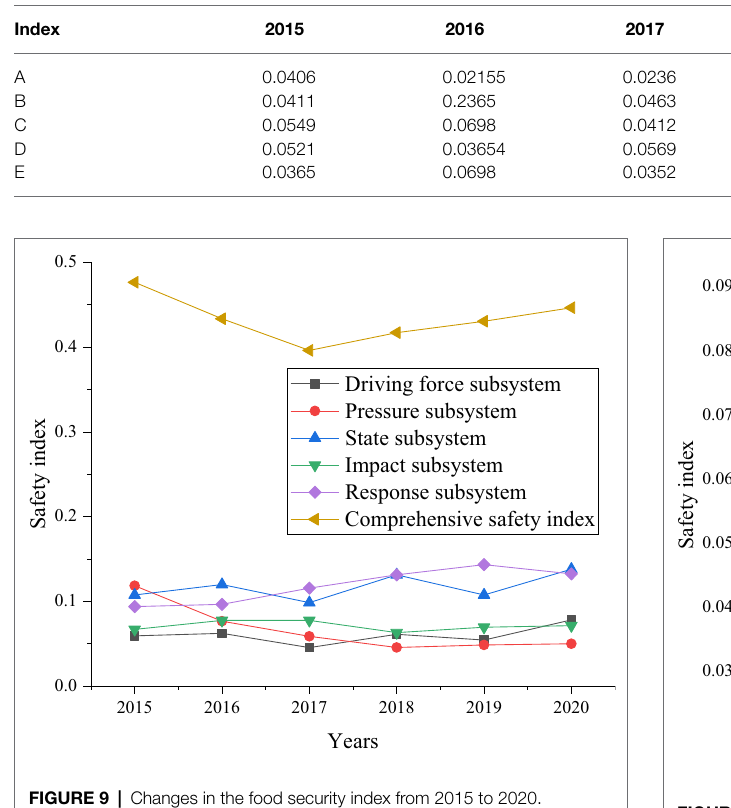
FIGURE 10 | From 2015 to 2020, the change trend of the food security impact response subsystem index.